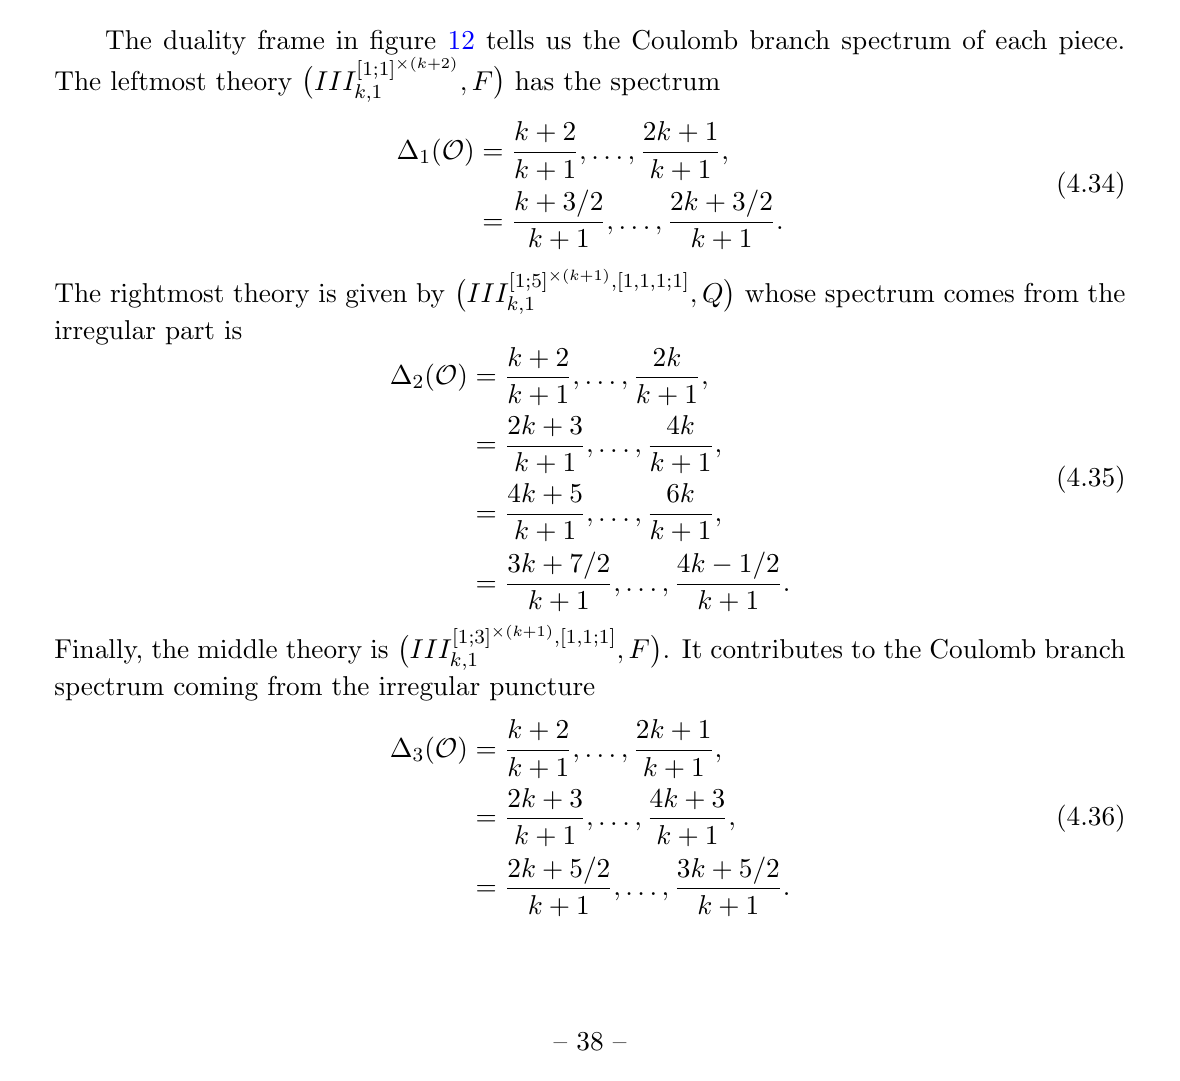
Figure 12 . S-duality for twisted D 4 theory of class ( k; 1) with large k . Each Argyres-Douglas matter is connected with Sp gauge group. Assembling the black dot and the blue square we can read o(cid:11) the data for the irregular puncture and thus identify the